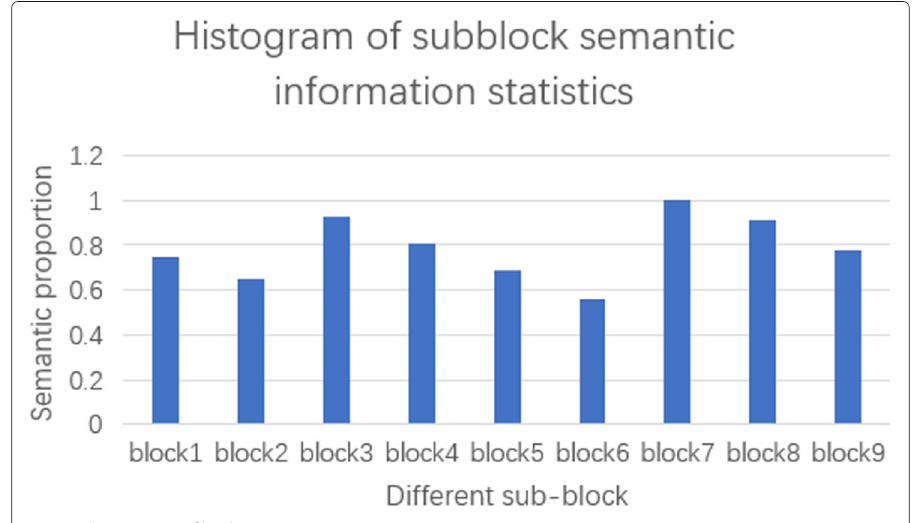
Fig. 5 The process of hash sequence